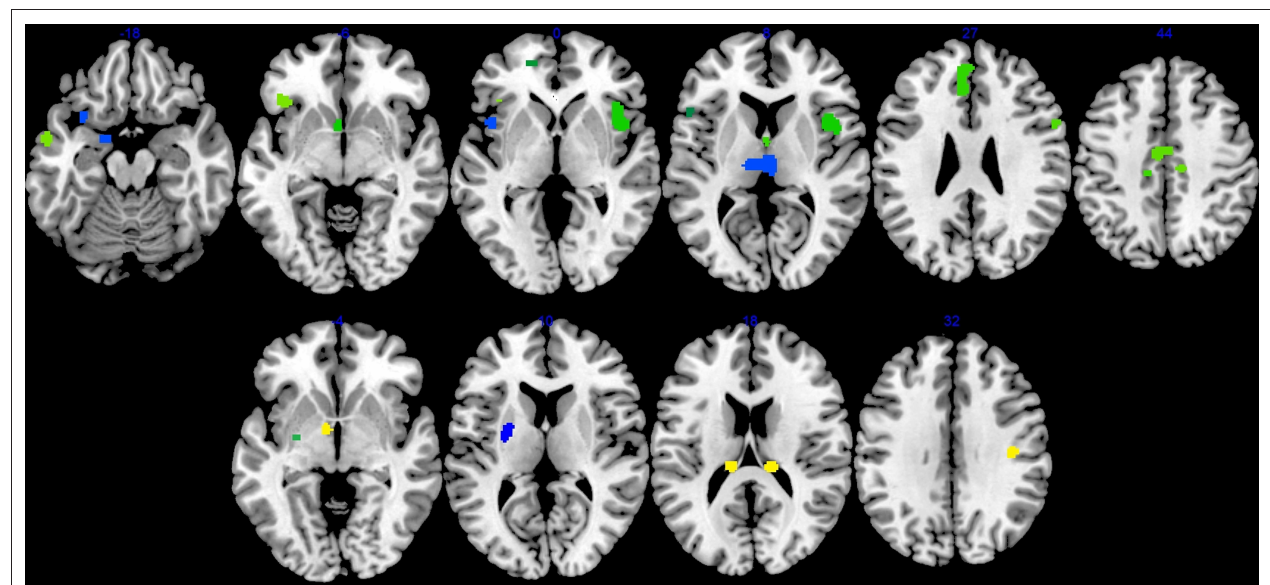
FiguRe 2 | Cerebral gray matter volume deficits (top panel) and excess (bottom panel) in schizophrenia and bipolar disorder compared with healthy controls. Blue clusters were driven mainly (greater than 80% distribution) by schizophrenia studies, while yellow were by bipolar studies. Green clusters were contributed by studies of both disorders (less than 80% distribution in either condition). Left side of brain is on left side of the panel.